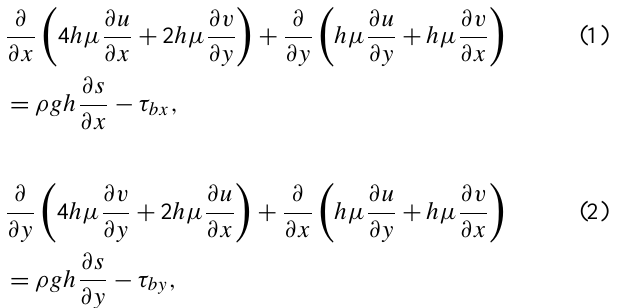
and standard parallel at +70 . Locations ◦ ◦